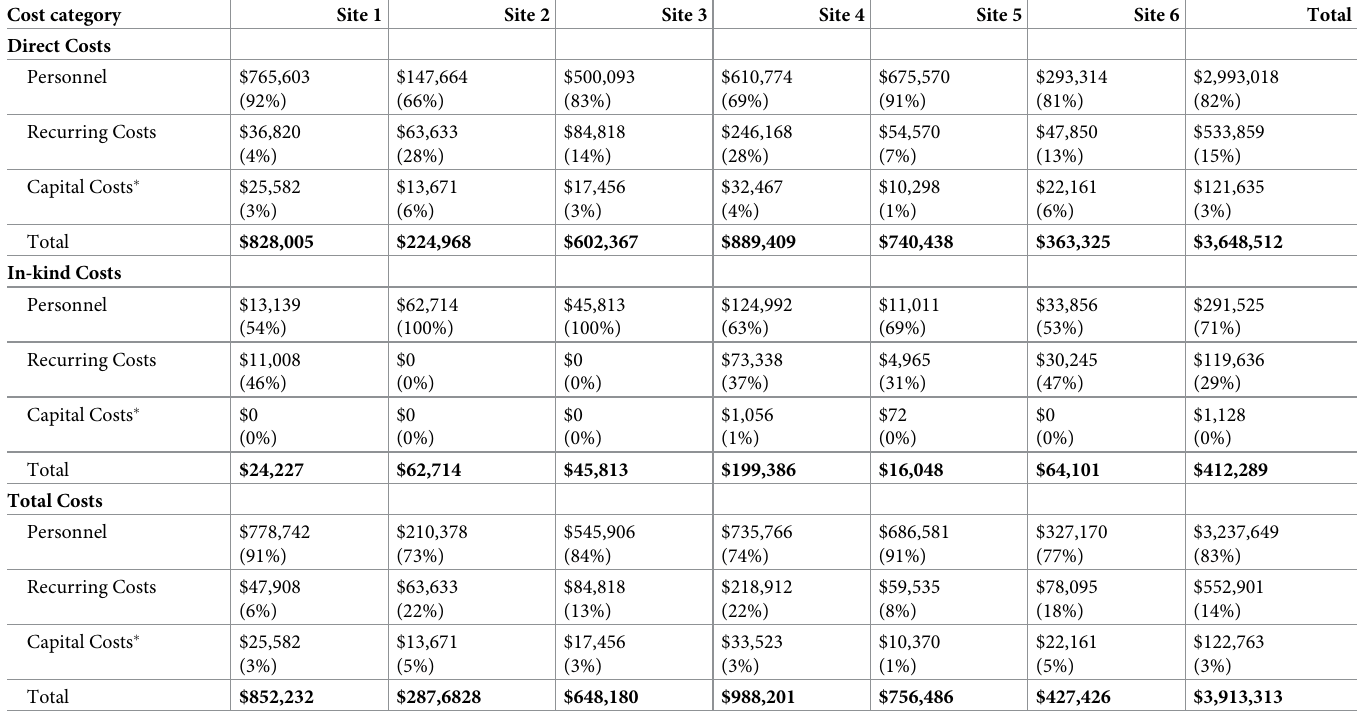
Table 1. Costs of HIT interventions by resources category and